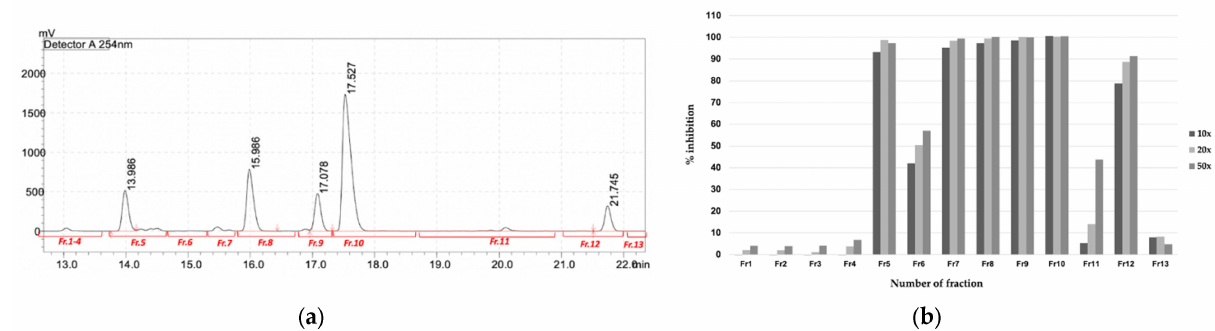
Figure 7. Purification of active compounds from FrA. ( a ) Semi-preparative HPLC chromatogram of the mixed active fraction, separated by a C 18 column. The chromatogram showed UV absorbance profile of the sample at wavelength of 254 nm. Red bars underneath the chromatogram represent time-coursed sampling of fractions collected during the analysis. ( b ) Inhibitory activity of fractions collected from semi-preparative HPLC against Pf MQO. Sample was concentrated 10 × (dark bar), 20 × (light bar) or 50 × (mid-dark bar) to represent a dose response of each